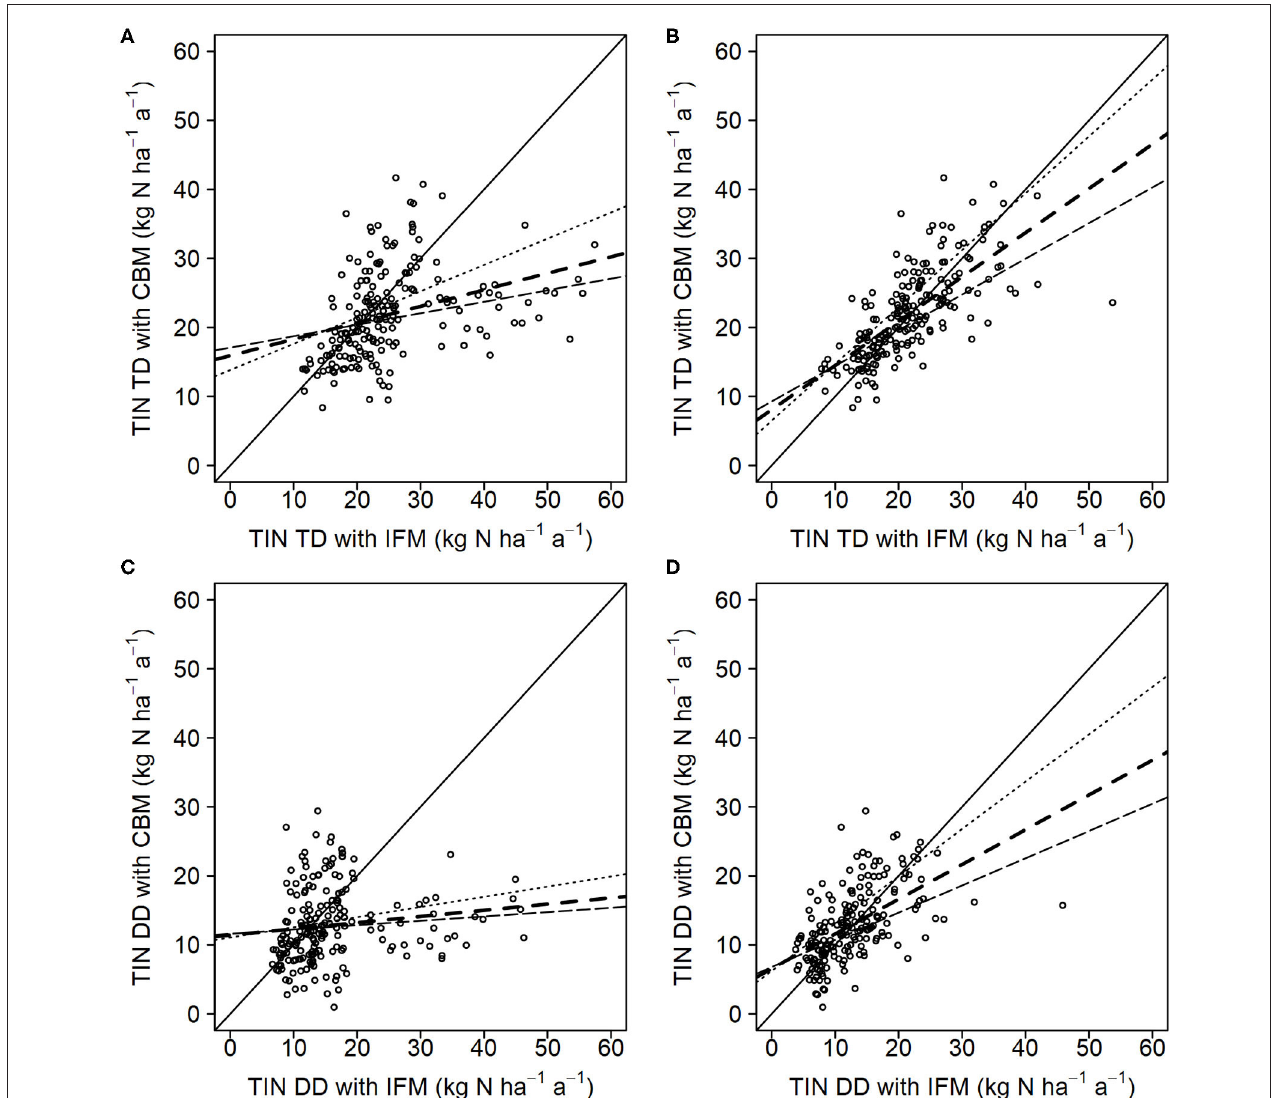
FIGURE 2 | Comparison of total deposition (TD) (A,B) and dry deposition (DD) (C,D) of total inorganic nitrogen (TIN) between canopy budget (CBM) and inferential method (IFM) ( n = 194 site-years from 42 sites). (A,C) calculated with forest type specific deposition velocities; (B,D) calculated with site specific deposition velocities. The solid black line represents the 1:1 line and the dashed lines represents the linear regressions lines for vd mean (- - - -), vd min ( ···· ), and vd max (——–) (see also Table 2 ). For vd min and vd max only the regression lines were displayed and not the individual points. All statistical parameters are given in Table 6